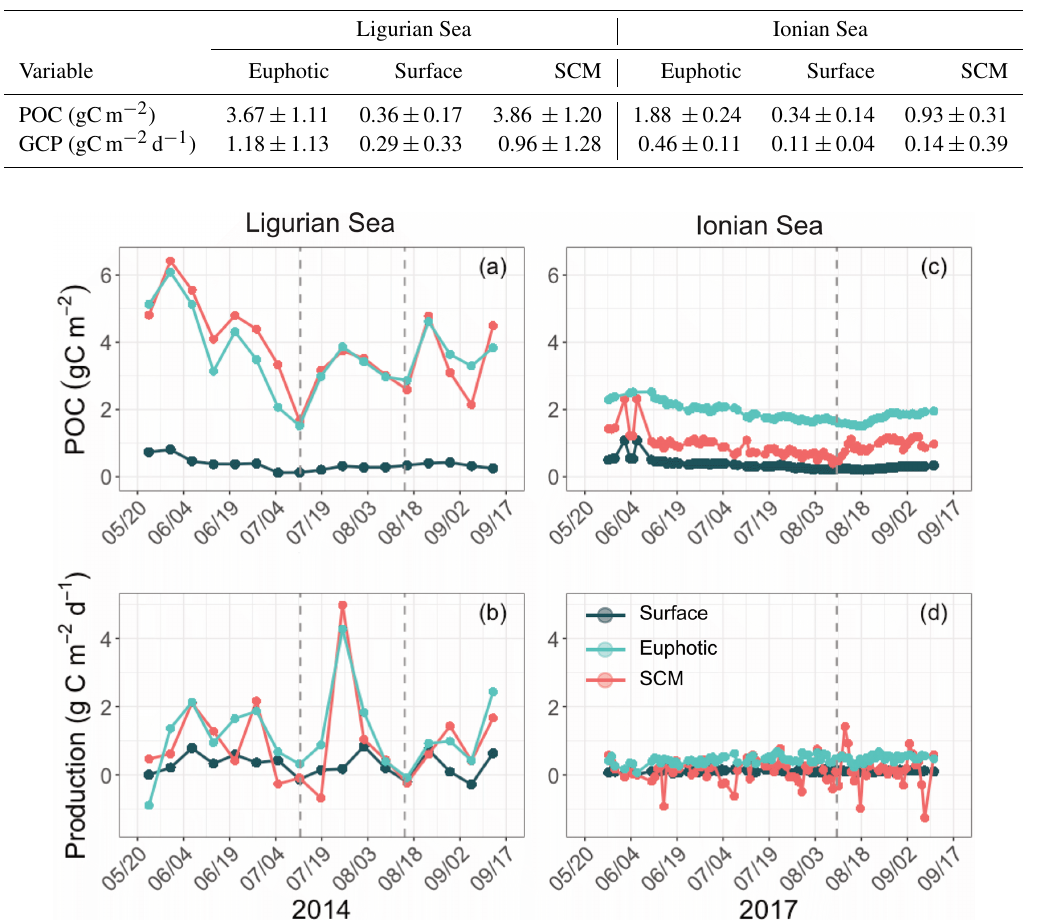
Table 6. Mean values ± SD of the stock of particulate organic carbon (POC) and rate of gross community production (GCP) derived from the diel cycle of c p in the two considered regions. The values are integrated within the surface, subsurface maximum (SCM) and euphotic layers.